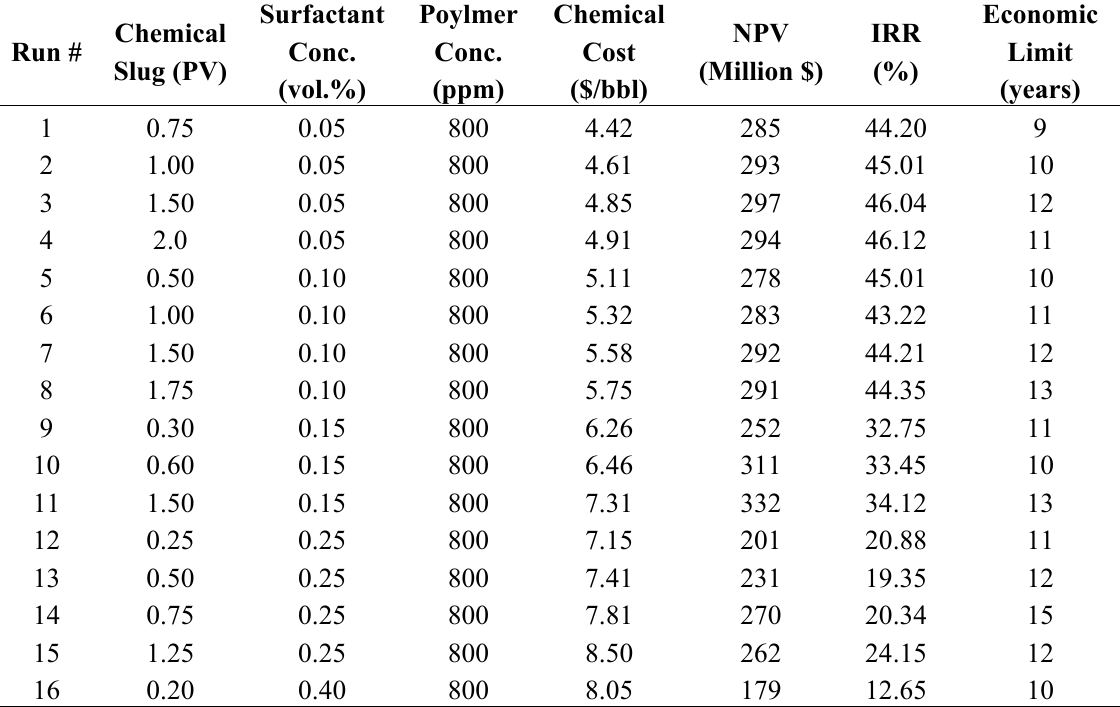
Table 3. Summary of economic